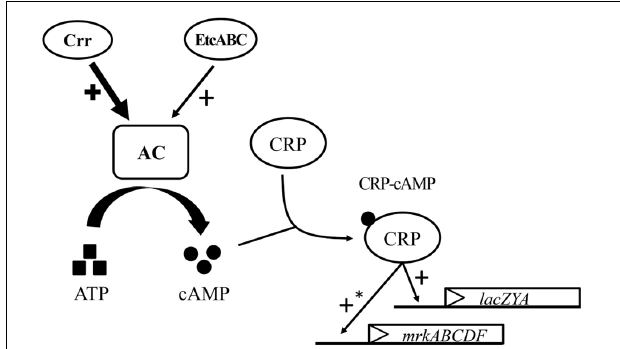
FIGURE 6 | Model for the role of etcABC in the regulation of type 3 fimbriae synthesis and lactose uptake in K. pneumoniae . In LB medium, Crr and/or EtcABC activate AC to produce cAMP. Then, cAMP binds to CRP to enhance the transcriptional activity of CRP. CRP-cAMP increases the transcription of lacZYA , resulting in bacterial lactose transportation and metabolism. CRP-cAMP increases the transcription of mrkABCDF , resulting in an increase in type 3 fimbriae production. The effect of Crr on AC is much greater than that of EtcABC in LB medium. An asterisk ( ∗ ) means indirect regulation. The possible mechanism was discussed in the Section